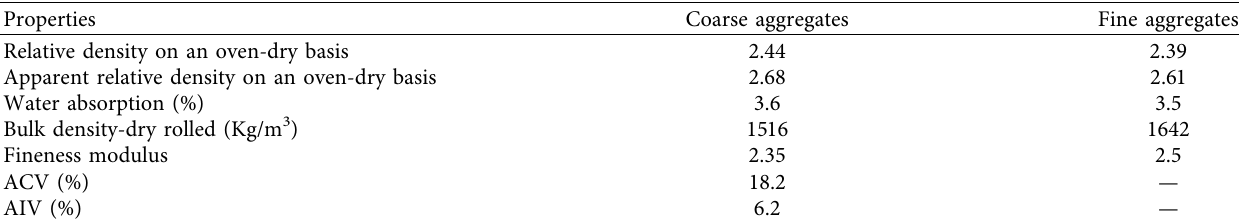
Table 2: Physical and mechanical properties of